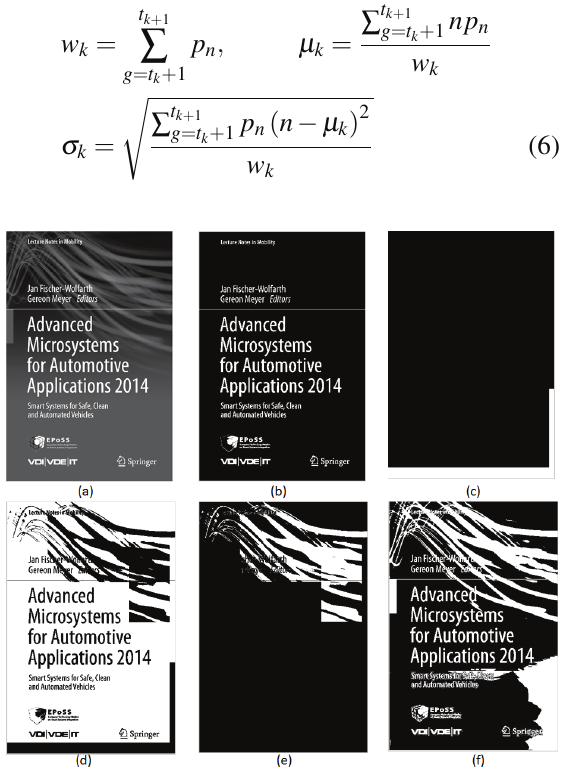
Figure 3: Result of clustering stage; (a) is the input grayscale image, (b),(c),(d),(e) is the 1st, 2nd, 3rd, 4th cluster, respectively, (f) is result of sauvola bina- rization for